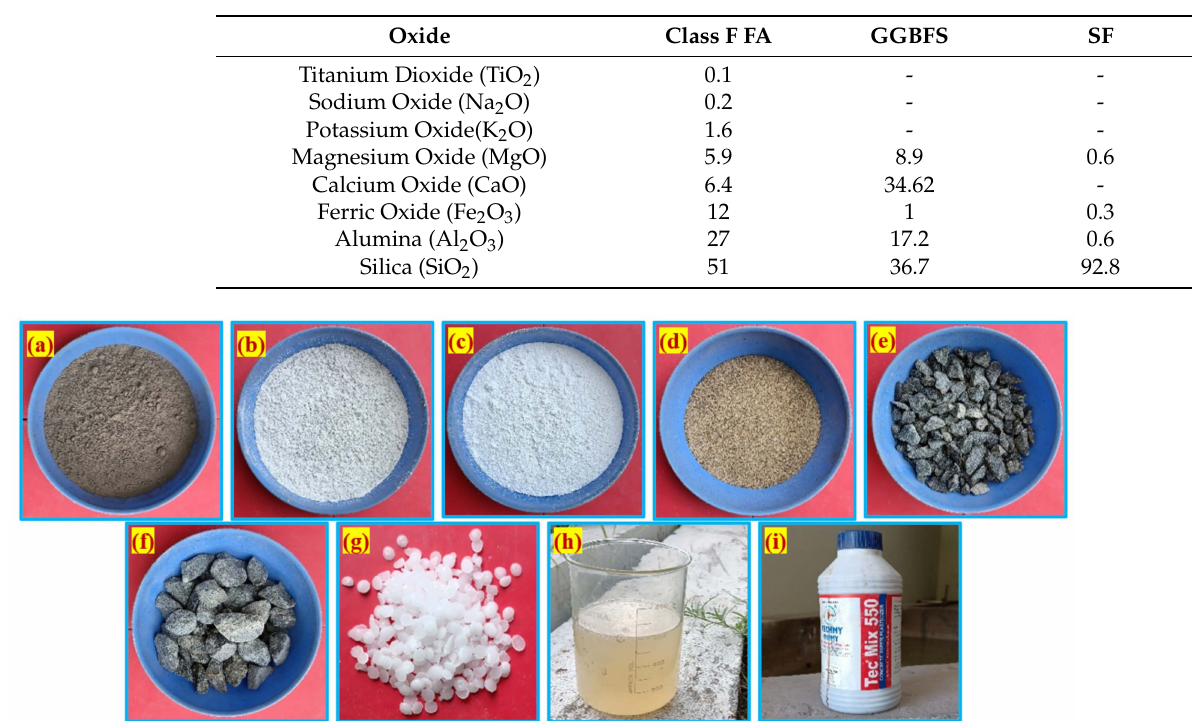
Table 2. Chemical composition of binders.